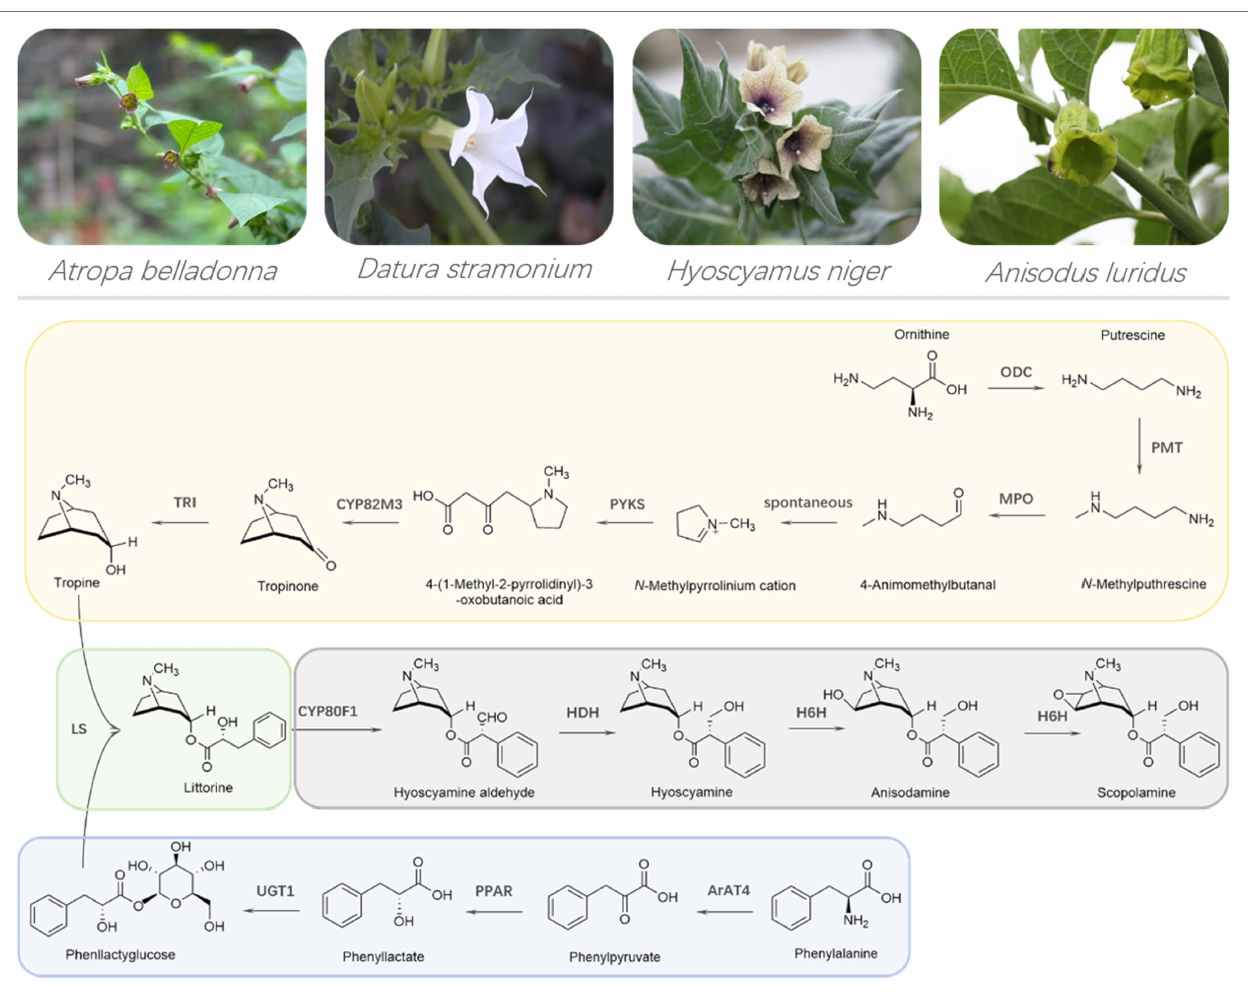
FIGURE 1 | Representative plant species producing medicinal tropane alkaloids and the intact biosynthetic pathway of medicinal tropane alkaloids. ODC, ornithine decarboxylase; PMT, putrescine N -methyltransferase; MPO, N -methylputrescine oxidase; PYKS, polyketide type III synthase; CYP82M3, tropinone synthase; TRI, tropinone reductase I or tropine-forming reductase; ArAT4, phenylalanine aminotransferase; PPAR, phenylpyruvic acid reductase; UGT1, phenyllactate UDP- glycosyltransferase; LS, littorine synthase; CYP80F1, littorine mutase; HDH, hyoscyamine dehydrogenase or hyoscyamine aldehyde reductase; H6H, hyoscyamine 6 β